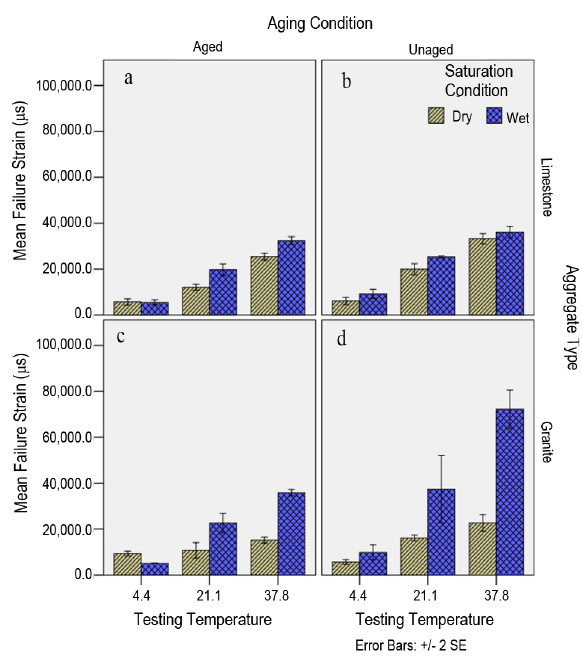
Fig. 11. Failure strain of: a) limestone aged mixtures; b) limestone un-aged mixtures; c) granite aged mixtures; d) granite un-aged mixtures